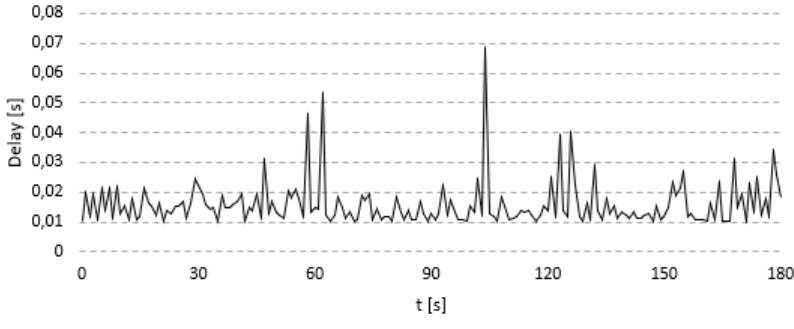
Figure 15. Delays obtained in the study